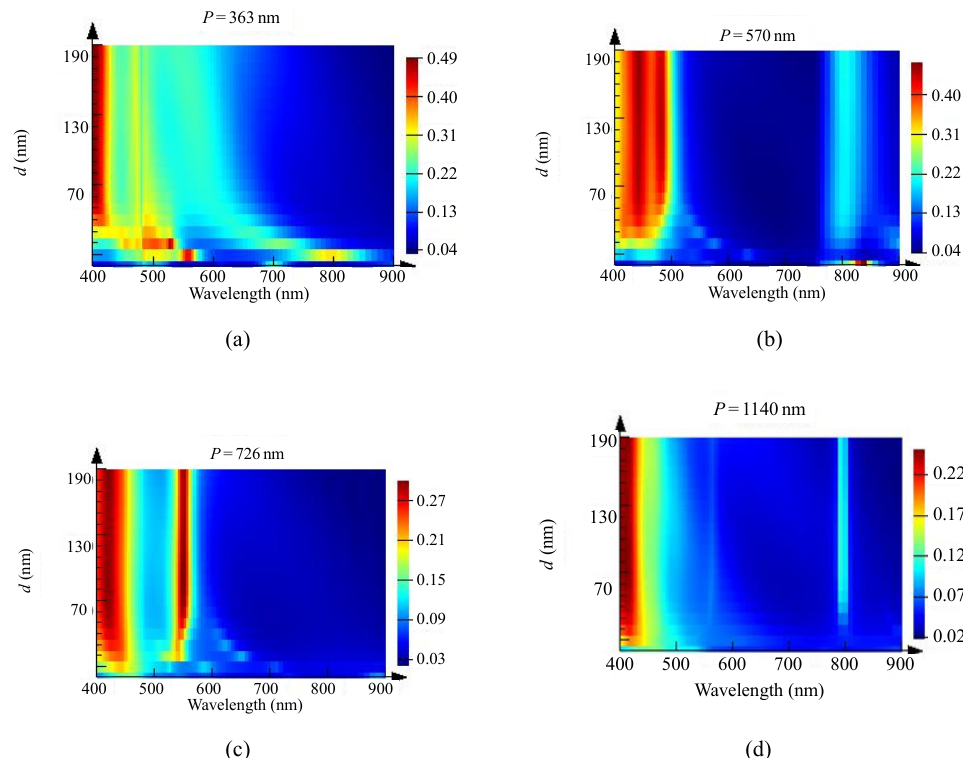
Fig. 5 Calculated absorbance as the function of the excitation light wavelength and Ag layer thickness for different periods: (a) − (d) correspond to P = 363 nm, 570 nm, 726 nm, and 1140 nm,